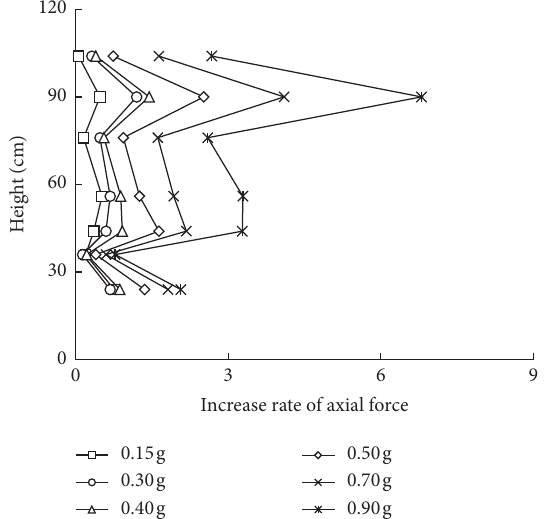
Figure 10: Variations of the increase rate of axial force under seismic motions with different amplitudes.